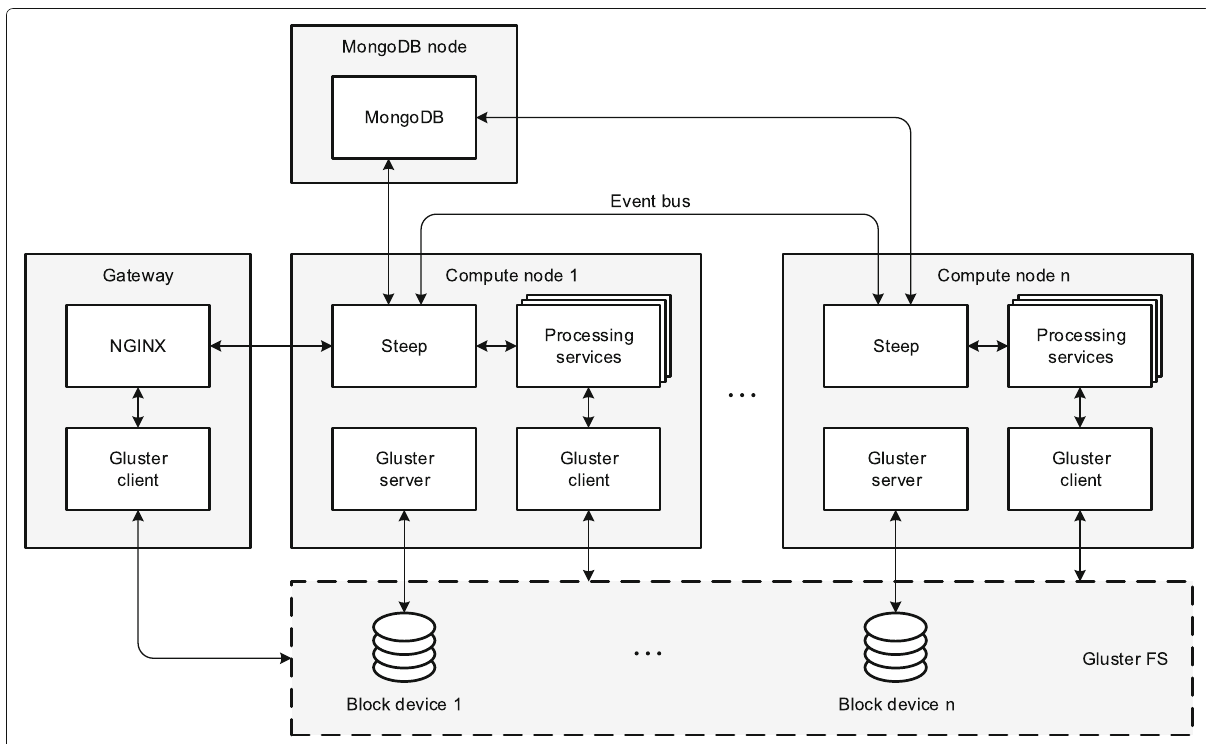
Fig. 14 Deployment of our workflow management system Steep in the AWS cloud